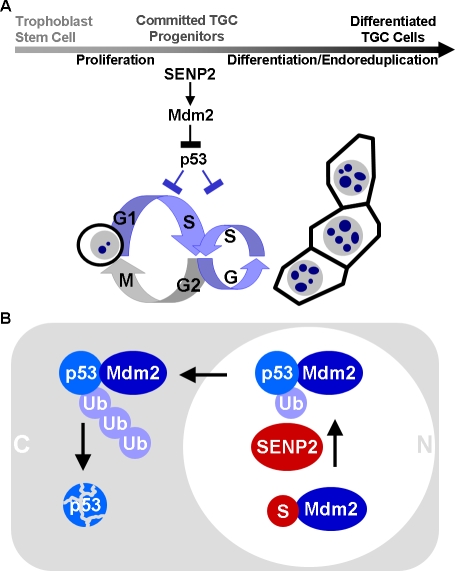
Model for the SENP2–Mdm2–p53 Pathway in Trophoblast Development(A) Diagram illustrating the p53–Mdm2 circuit regulated by SENP2 in the trophoblast cell cycle. Stimulation of Mdm2 by SENP2 leads to degradation of p53. Cellular levels of p53 control the G–S transition that has a dual role in TGC development. The G–S phase is required for both mitotic division (cell cycle: G1, S, G2, and M) and endoreduplication (endocycle: G and S only) during expansion of trophoblast stem cells and maturation of trophoblasts, respectively. Although a low p53 level is essential for stem cell proliferation, inhibition of p53 is required upon differentiation.(B) Schematic representation for the mechanism underlying the regulation of p53 and Mdm2 by the SUMO pathway. SENP2 activates Mdm2 by removing SUMO that permits the modulation of p53 by Mdm2 in the nucleus. The ubiquitin-conjugated p53 is then degraded in the cytoplasm.